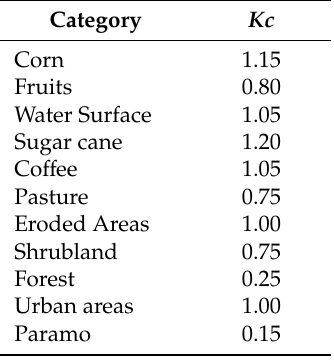
Table 1. Specific crop coe ffi cient ( Kc ) used for the present